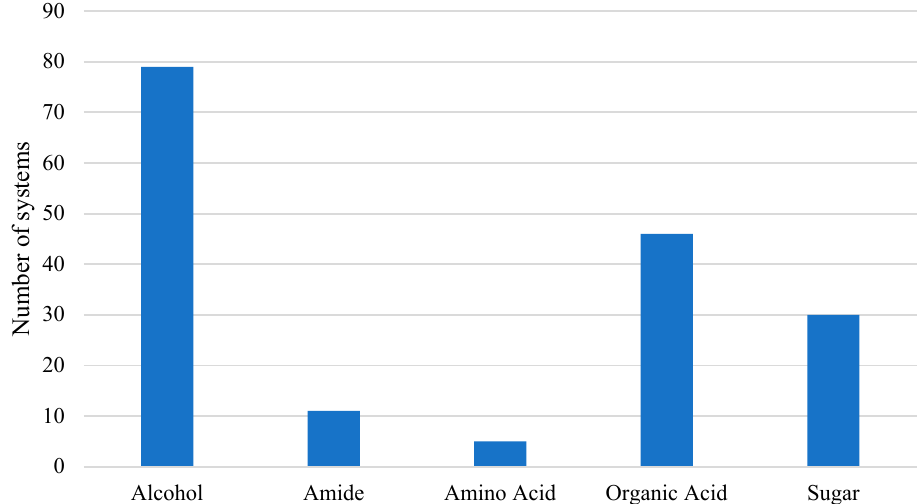
Figure 4. Distribution of the different hbds studied, organized by funtional group with alcohol-, organic-acid-, and sugar-based systems being the most common.